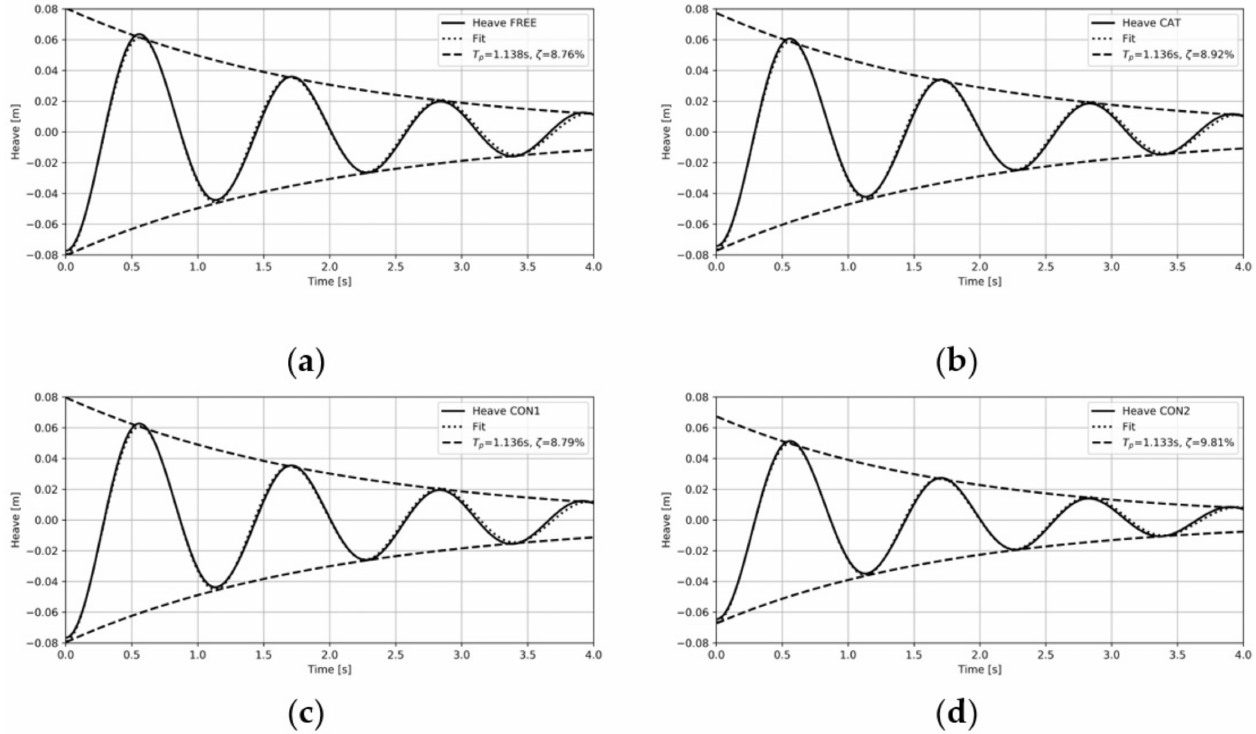
Figure 12. Time series to estimate the natural period and percentage of critical damping for the decaying heave motion of: ( a ) the free buoy; ( b ) and of the buoy with mooring systems CAT; ( c ) CON1, ( d ) and